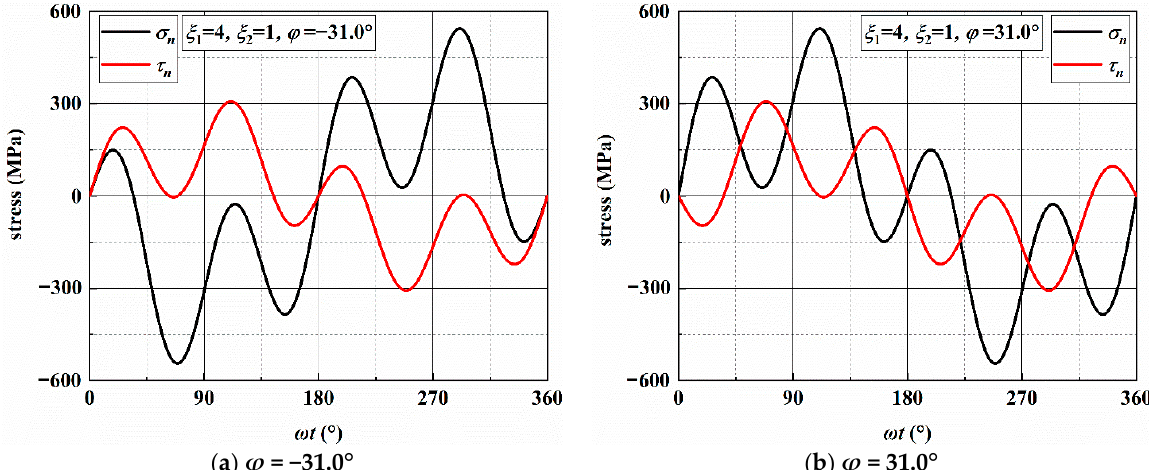
Figure A4. Variation of normal and shear stress on MN plane under AS-2.